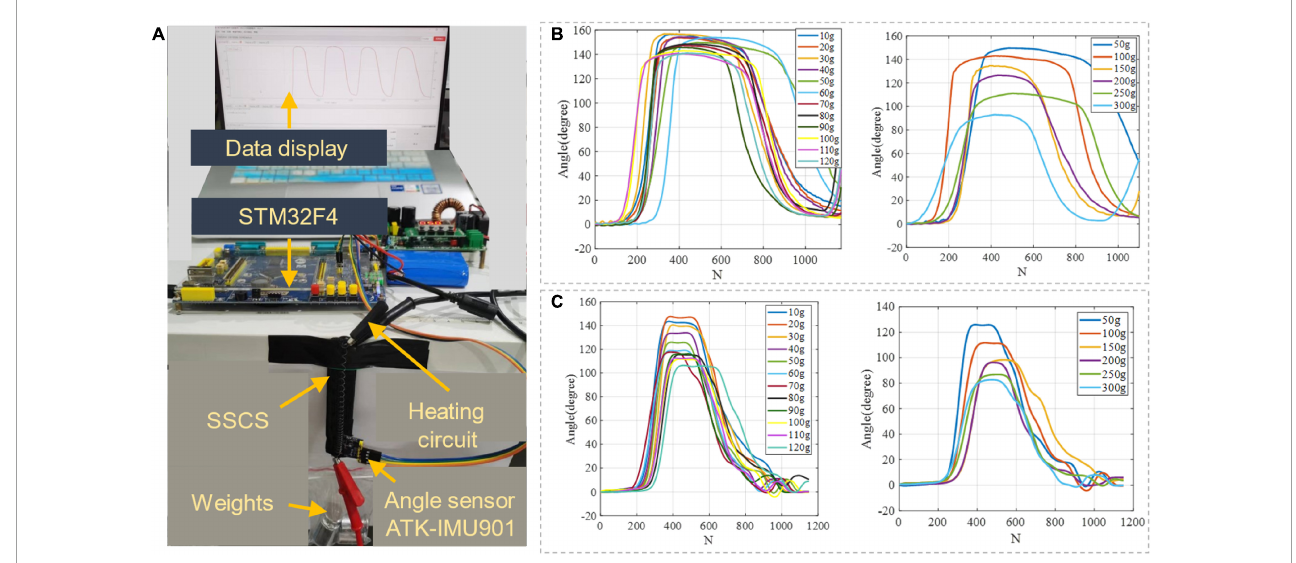
FIGURE8 Output force and displacement performance of SSCS. (A) The experimental setup, (B,C) are the experimental results of SSCS with d = 0.1 and 0.2 mm, N ( N = 62) is the number of samples.